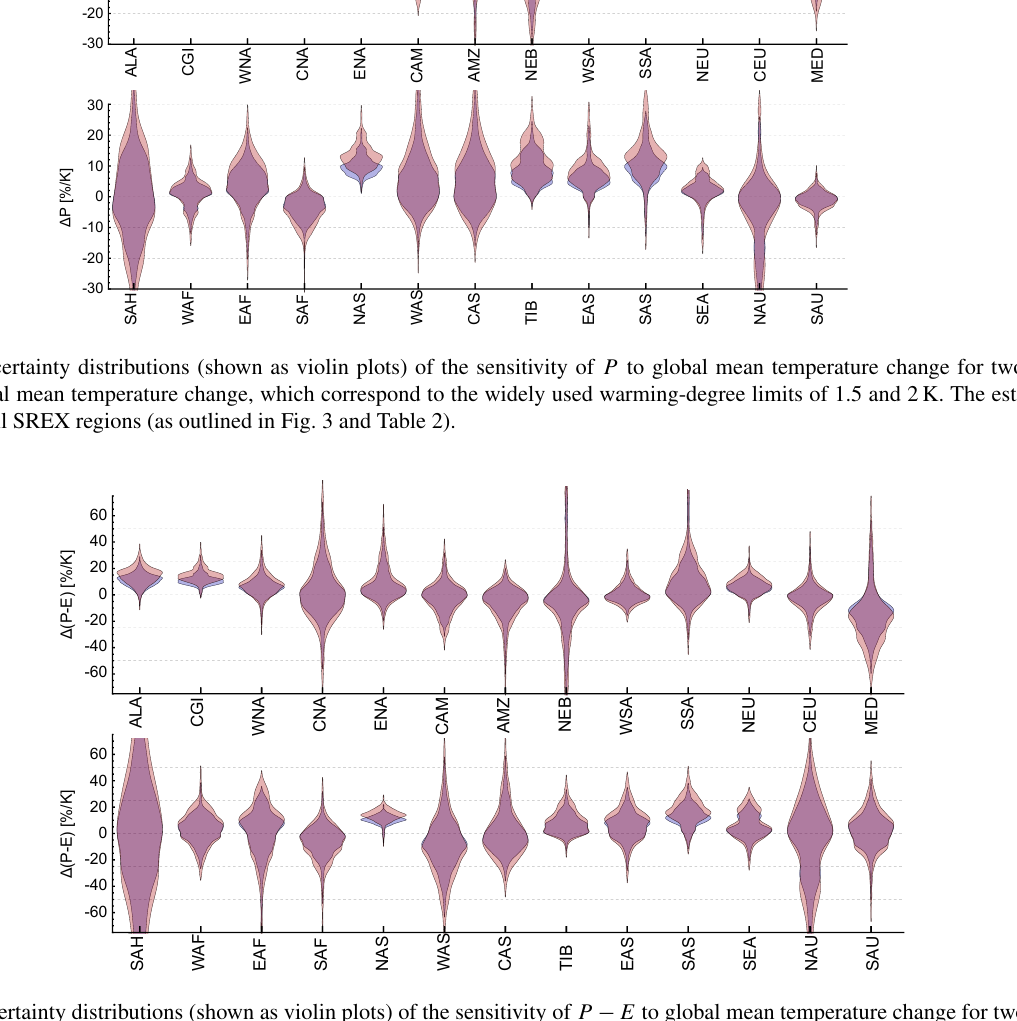
Figure 11. Uncertainty distributions (shown as violin plots) of the sensitivity of P − E to global mean temperature change for two different degrees of global mean temperature change, which correspond to the widely used warming-degree limits of 1.5 and 2K. The estimates are averaged over all SREX regions (as outlined in Fig. 3 and Table 2). It is important to note that the data considered to estimate the area average are scarce in some regions (e.g. SAH). Please also refer to Fig. 10 for more